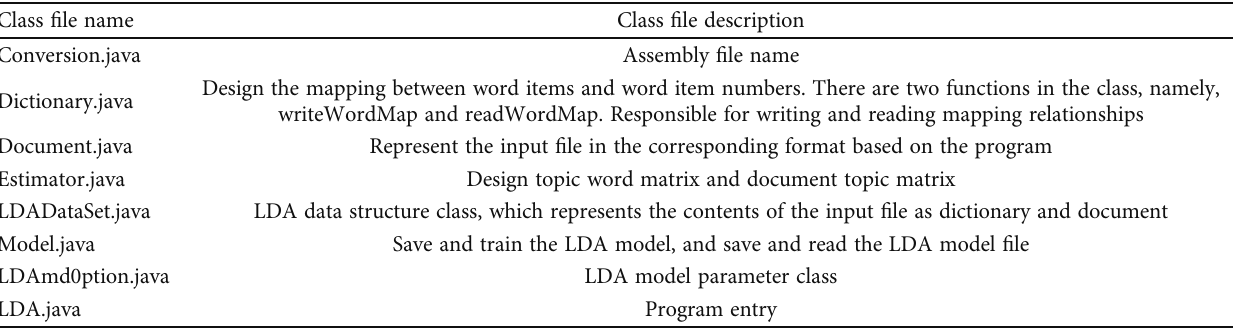
Table 2: JGibbLDA class fi le